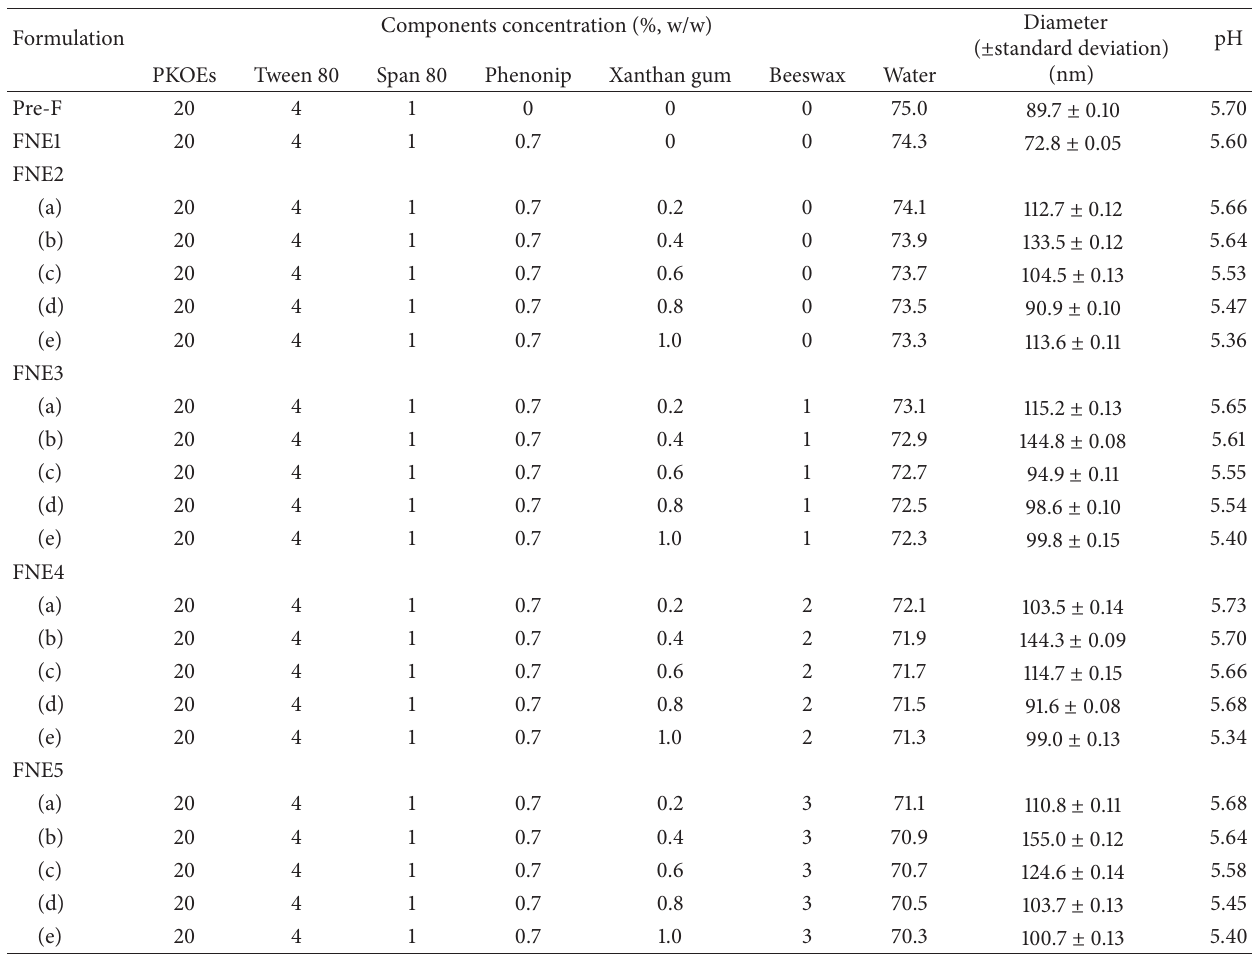
Table 3: Composition and physicochemical characteristics of FNE